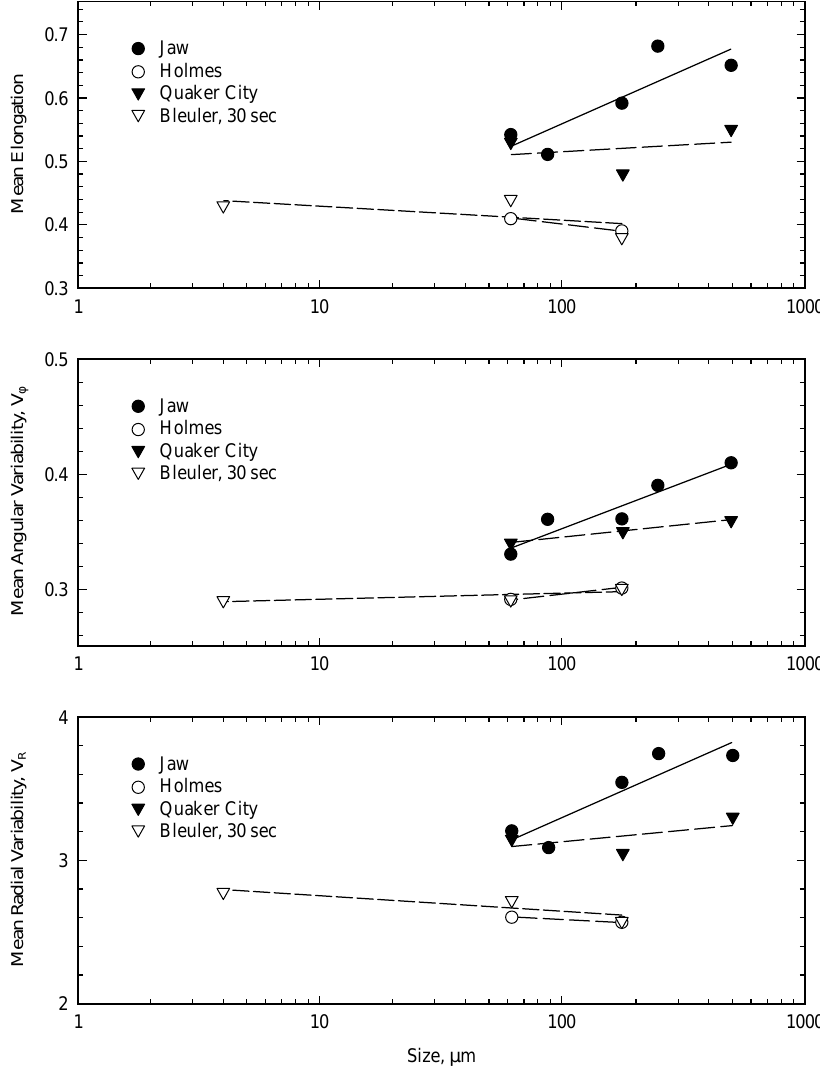
Fig. 6 Variation in shape with particle size for coal ground in different